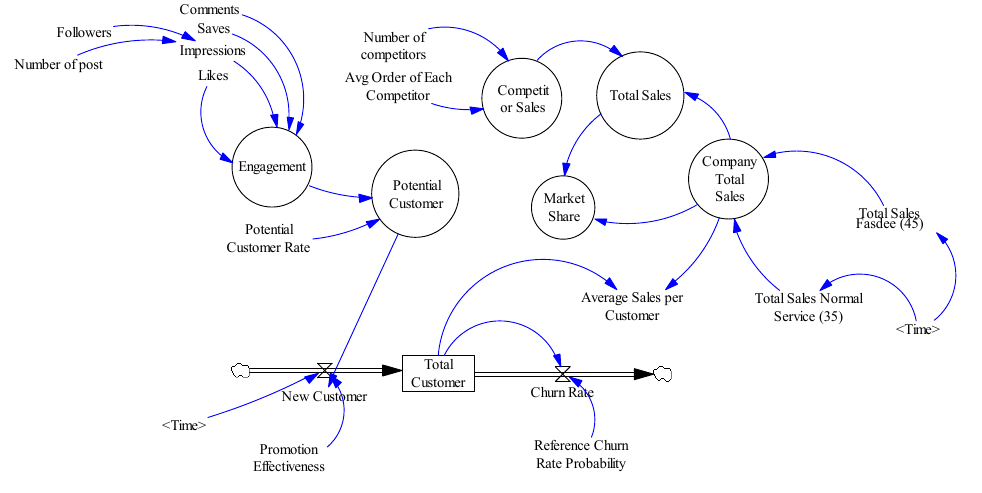
Fig. 2 SFD of customer, order, engagement, and market